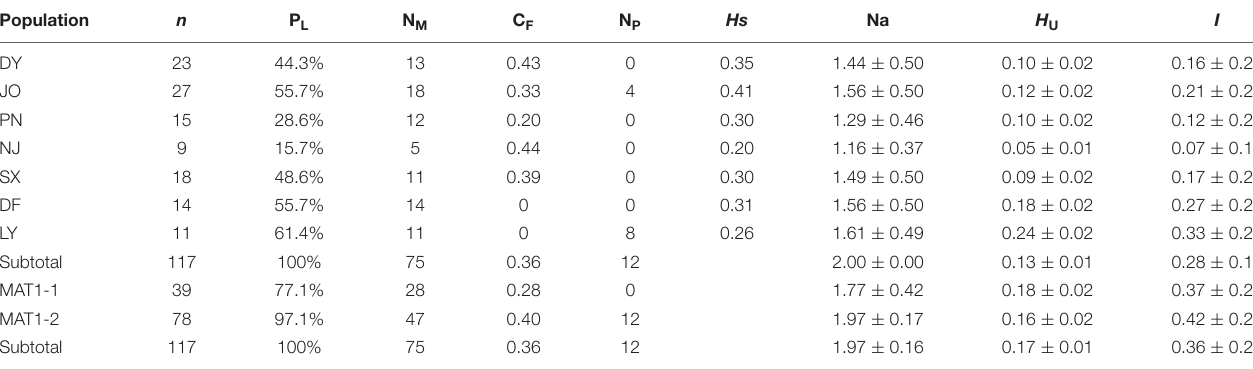
TABLE 2 | Genetic diversity among regional and between mating type populations of Setosphaeria turcica in Fujian Province based on an analysis of inter-simple sequence repeat markers. Population